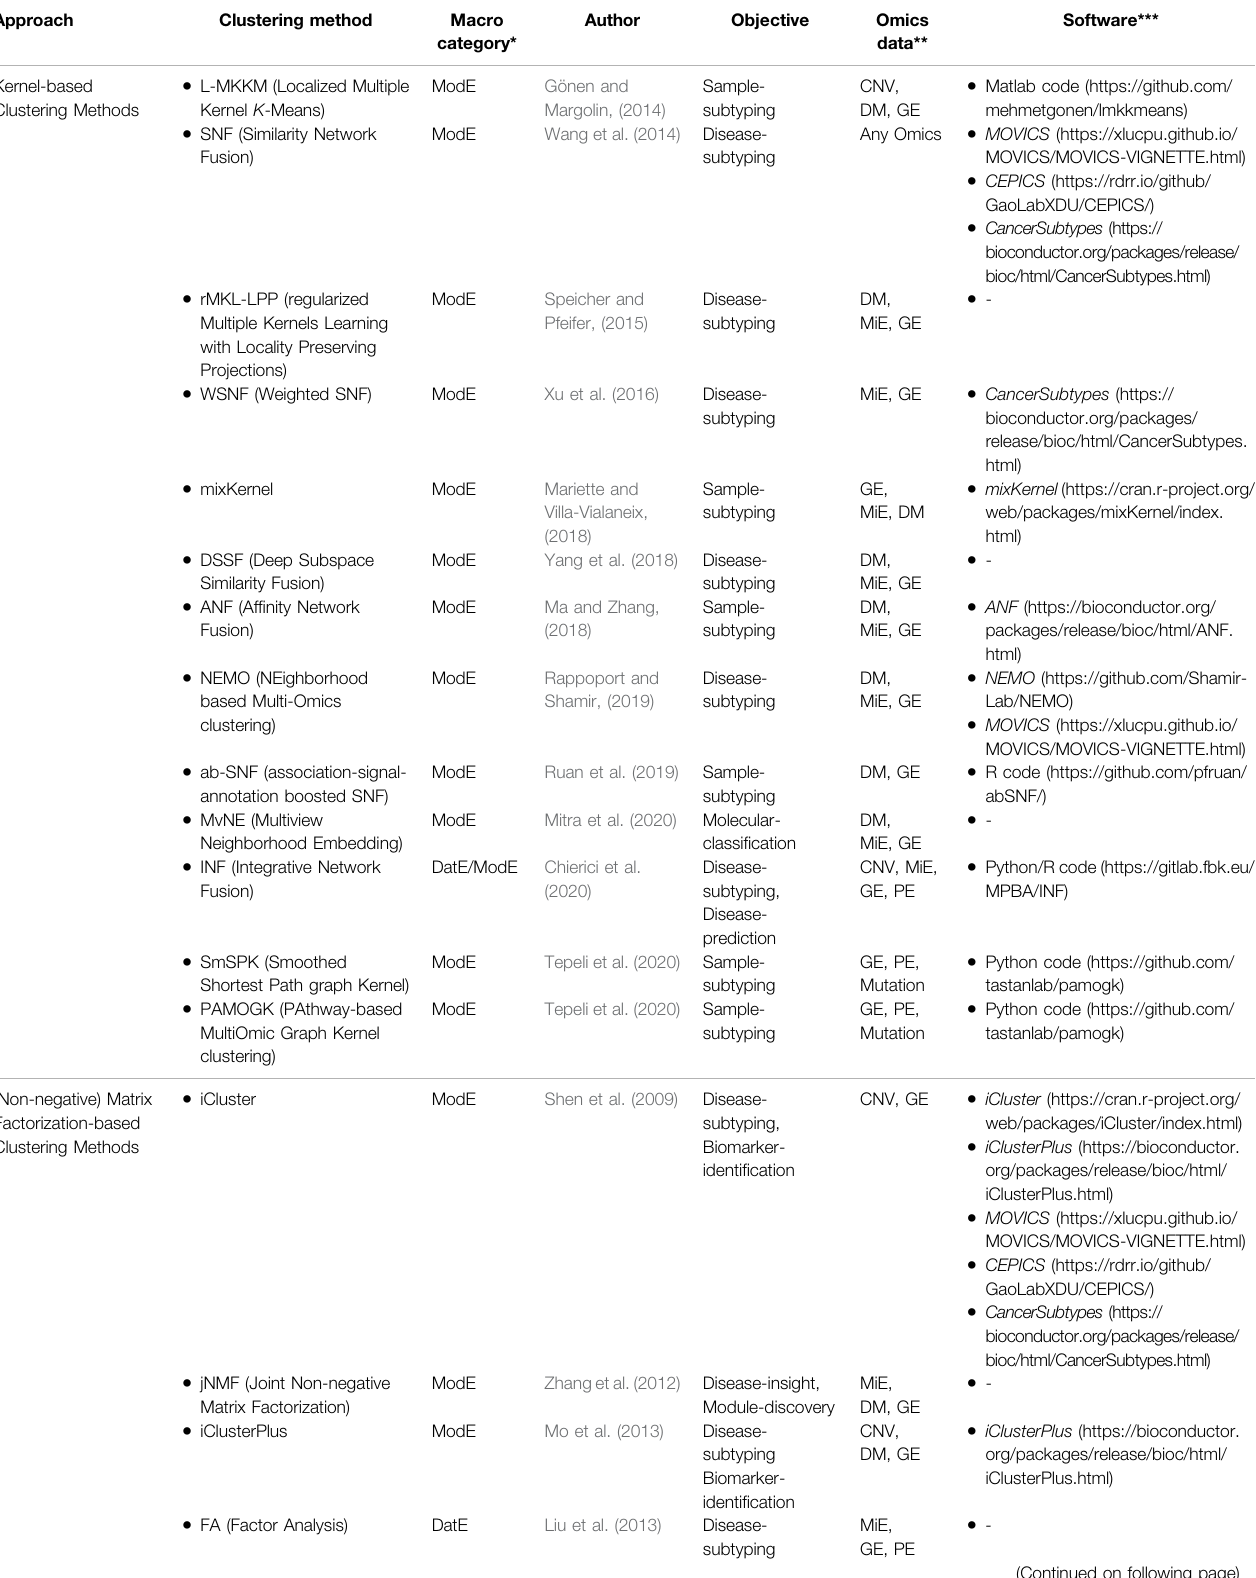
TABLE 3 | Low-level: Clustering-based unsupervised integration